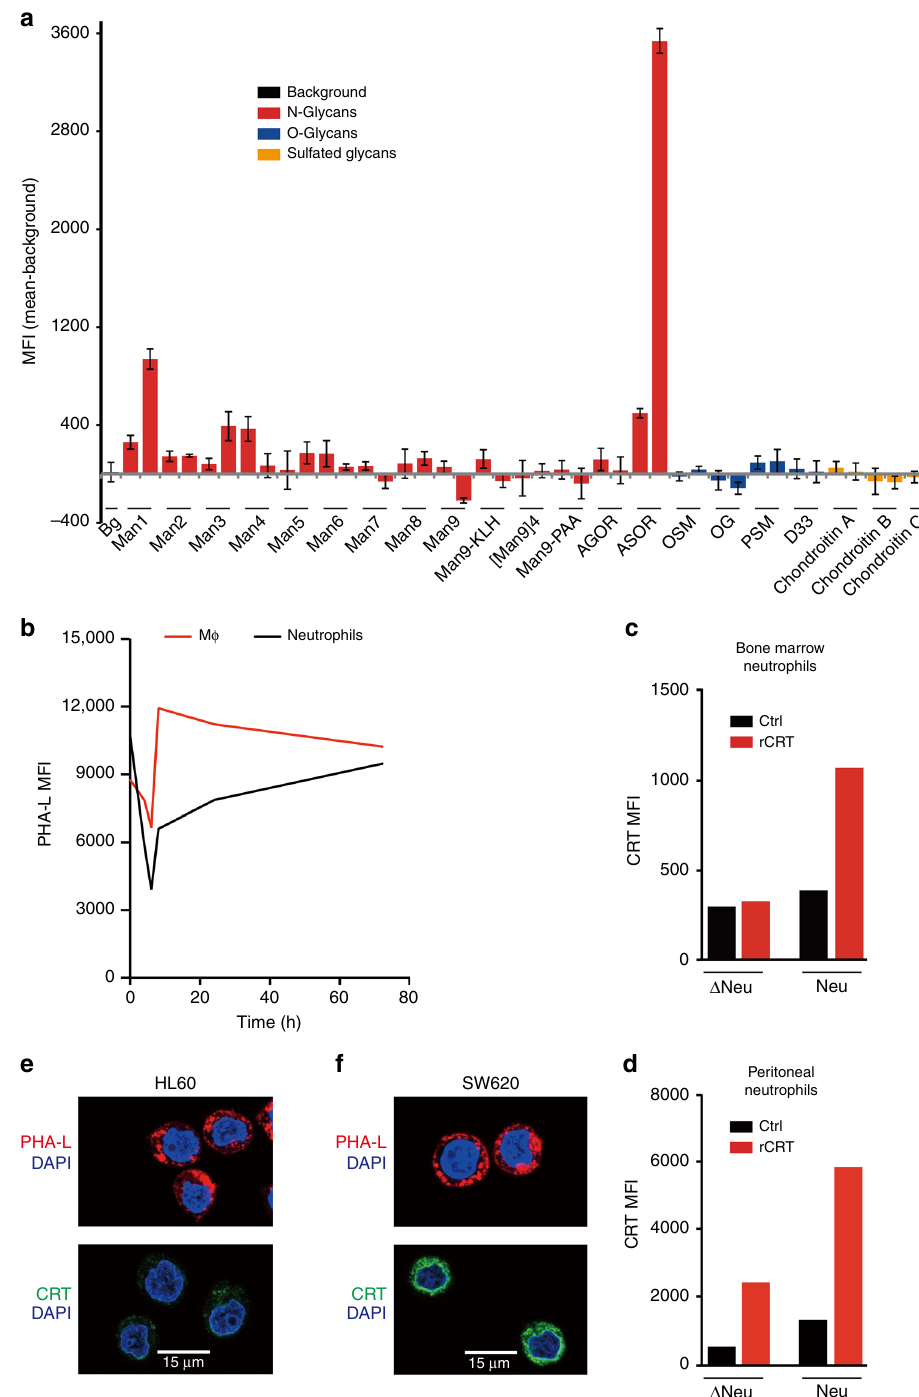
Fig. 4 Identi fi cation of CRT-binding ligands on aged and malignant cells. a Screening for CRT-binding glycans with carbohydrate microarray. Puri fi ed CRT- IgG-Fc proteins were used to probe a carbohydrate microarray containing a number of different types of glycans, including N-, O- and sulfated-glycans. Anti-IgG-Fc antibody was used for detecting binding of CRT to glycans. Glyco-antigens were used at 0.05 and 0.25 μ g μ l − 1 (left and right bars for each glycan). n = 3. Error bars represent standard deviation. b PHA-L binding to peritoneal neutrophils and macrophages at 0, 4, 6, 8, 24, and 72 h after thioglycollate injection in MRP8-Bcl2 mice. c , d Examination of cell surface CRT-binding sites on neutrophils. Bone marrow ( c ) or peritoneal neutrophils ( d ) were collected and treated with heat inactivated neuraminidase ( Δ neu) or neuraminidase (neu). Cells were incubated with PBS (control; black) or recombinant CRT proteins (red) and binding of CRT was then measured by fl ow cytometry with PE-conjugated anti-CRT antibody. rCRT binds to mature peritoneal neutrophils but not the immature bone marrow neutrophils. Treatment with neuraminidase led to the release of CRT-binding sites. e , f Immuno fl uorescent staining of CRT in HL60 ( e ) and SW620 ( f ) cells. CRT localized to perinuclear regions, vesicles, and cell surface. CRT was either expressed at a low level ( e ) or limited to the perinuclear regions ( f ), while a signi fi cant portion of PHA-L staining were observed on the cell surface ( e and f ).In a – d , MFI, mean fl uorescence